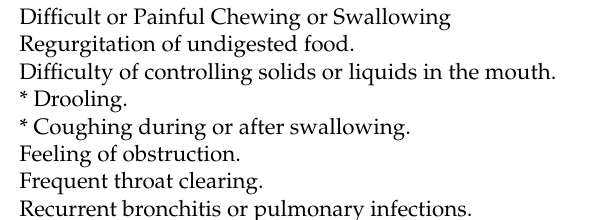
Table 2. Clinical signs of